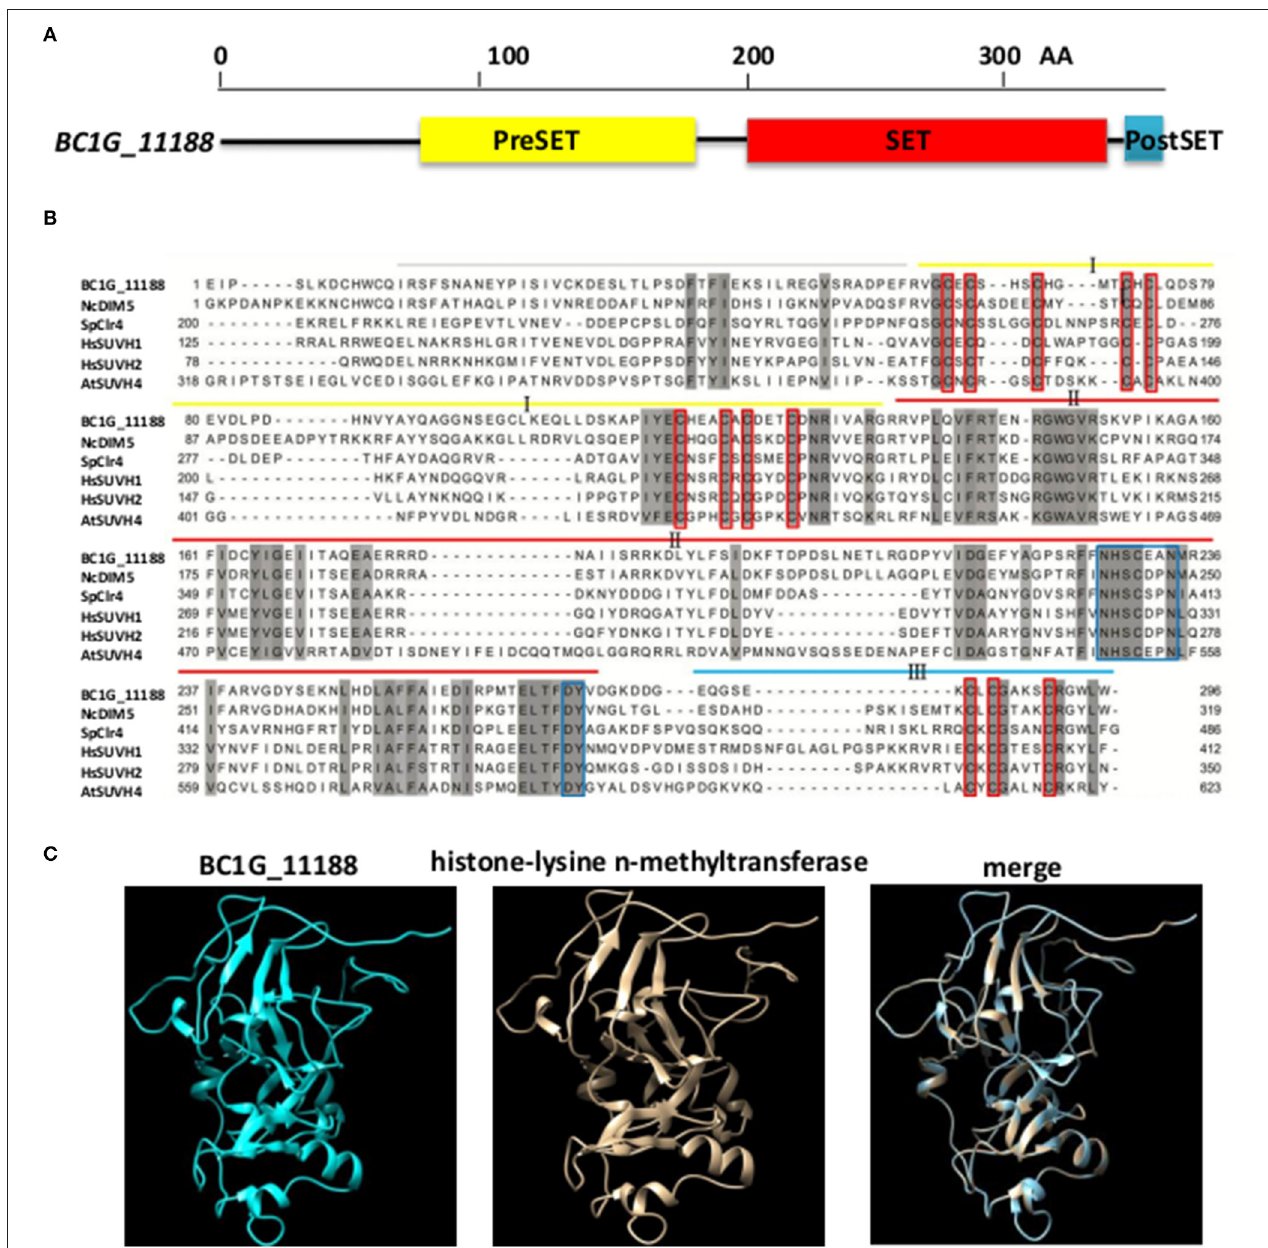
FIGURE 1 | BcDIM5 was predicted as a H3K9 methyltransferase in B. cinerea. (A) Schematic illustrations of BcDIM5 . The conserved domains were predicted by the SMART web site. (B) Multiple sequence alignment of H3K9 methyltransferase. Comparison of the DIM5 from Botrytis cinerea ( BcDIM5 ), Neurospora crassa ( NcDIM5 ), Schizosaccharomyces pombe ( SpClr4), Homo sapiens ( HsSUVH1 and HsSUVH2 ), and Arabidopsis thaliana ( AtSUVH4 ). The more similar the amino acids are, the darker the background is. (C) Representation of the three-dimensional structure of H3K9 methyltransferase and predicted BcDIM5 . Total residues were modeled with 100% confidence by the single highest scoring template H3K9 methyltransferase (c4qeoA) in the Phyre